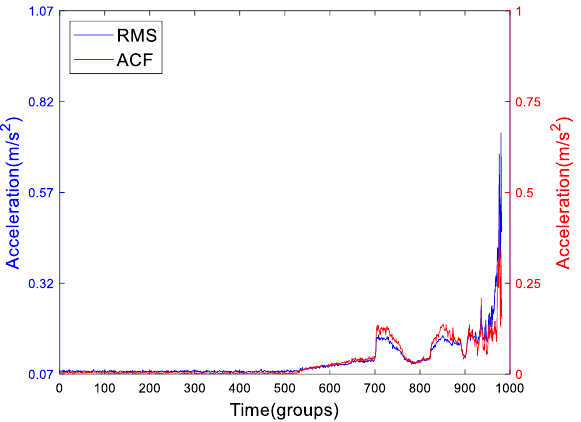
Figure 7. The ADF of Bearing2-1IMS compared with RMS.